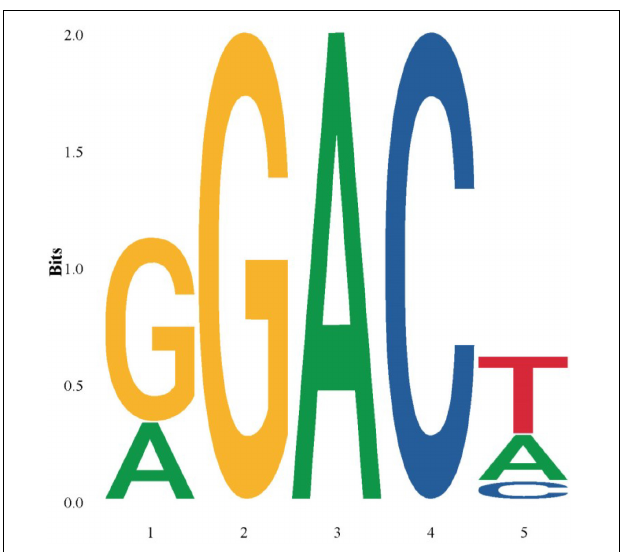
FIGURE 11 | The consensus motifs of m6A methylation sites. The height of the base signal represents the relative base frequency of each